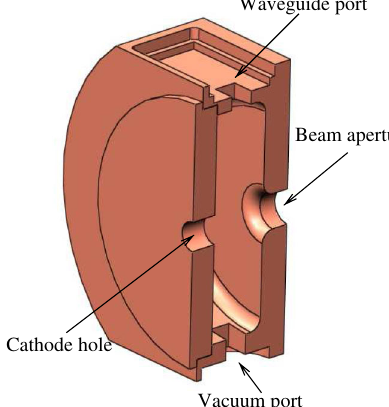
FIG. 10. 3D view of the test cavity.